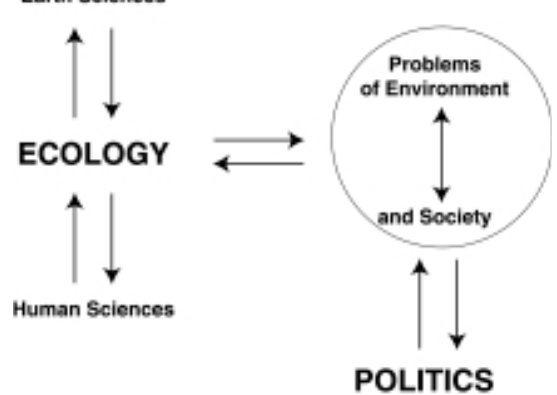
Fig. 3. The meeting between ecology and politics occurs around environment problems – that is society questions. When tackling environmental issues ecology is necessarly confronted to human sciences and has also to take profit of competences bring up by earth